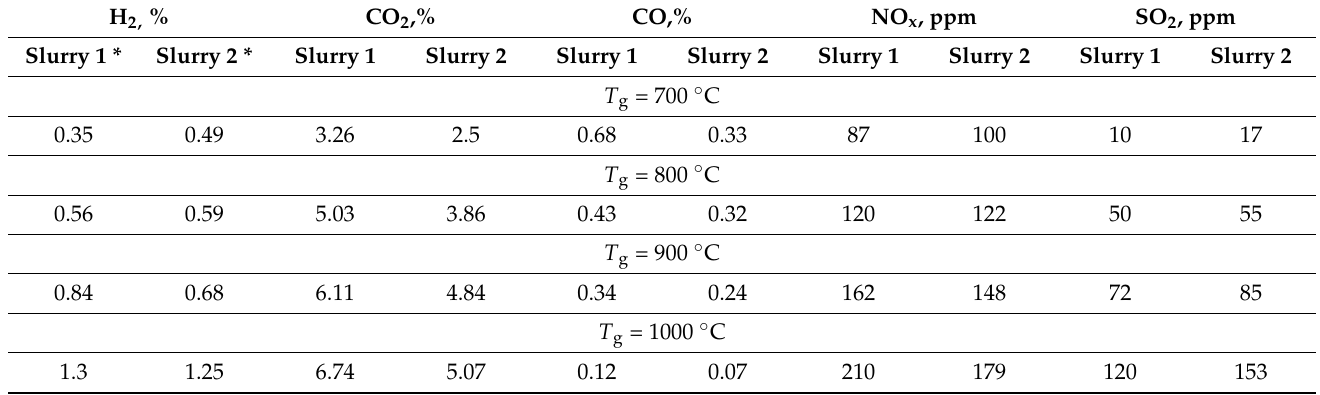
Table 5. Average concentrations of gases from the combustion of slurry droplets with varying temperature in the combustion